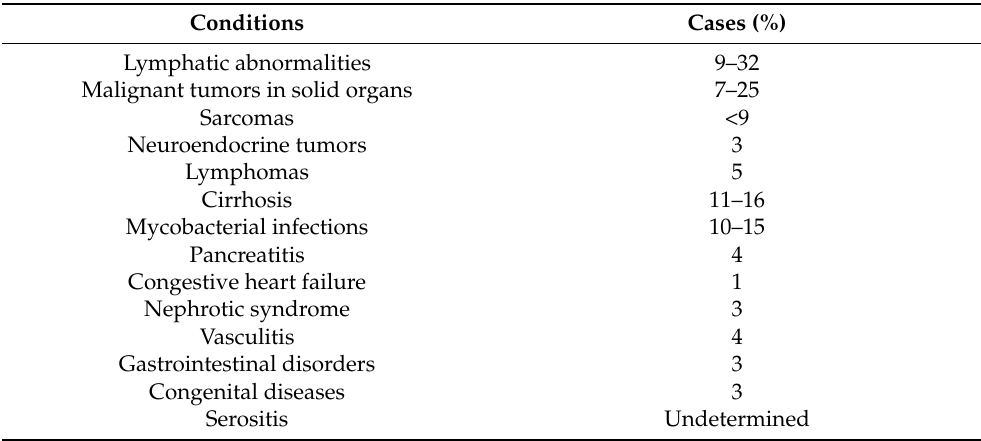
Table 1. Differential diagnoses to consider in non-traumatic chylous ascites